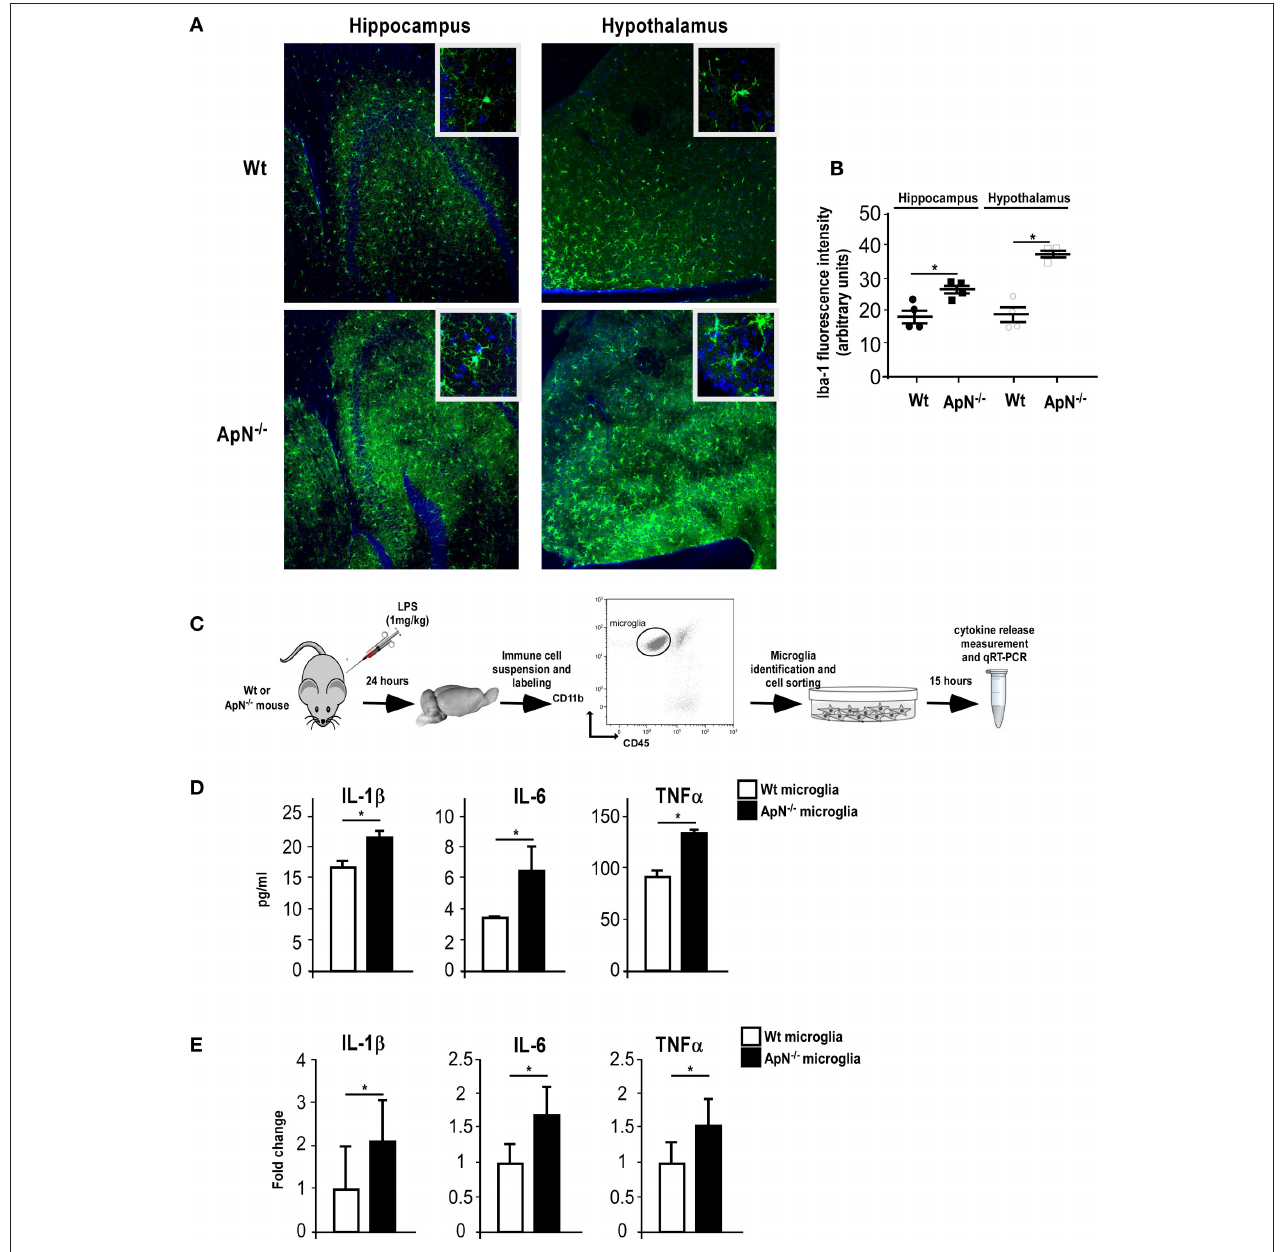
FIGURE 2 | Adiponectin deficiency leads to microglia hyper-responsiveness toward LPS. (A) Representative images of Iba-1-immunoreactive microglia (green fluorescence) in hippocampus (left panels) and hypothalamus (right panels) from Wt (upper panels) and ApN − / − (lower panels) mouse brains, 24h after LPS challenge. Nuclei are stained with Hoechst fluorescent dye (blue fluorescence). All images were taken under the same parameters. (B) Quantification of Iba-1 staining using fluorescence intensity values to quantify Iba-1 levels. (C) Schematic representation of the protocol. 24h after LPS ip injection, IL-1 β , IL-6, and TNF α proteins (D) or mRNAs (E) were quantified by CBA or qRT-PCR, respectively, from microglia sorted from brain cell suspensions of Wt (white bars) or ApN − / − mice (black bars) cultured for 15h. (D) Data represent the mean concentration SEM, n 4. (E) Data represent the mean expression levels s expressed as fold change compared ± = ± to LPS-treated Wt mouse microglia, n 4. Mann & Whitney for comparison between groups, * p < 0.05, vs. =